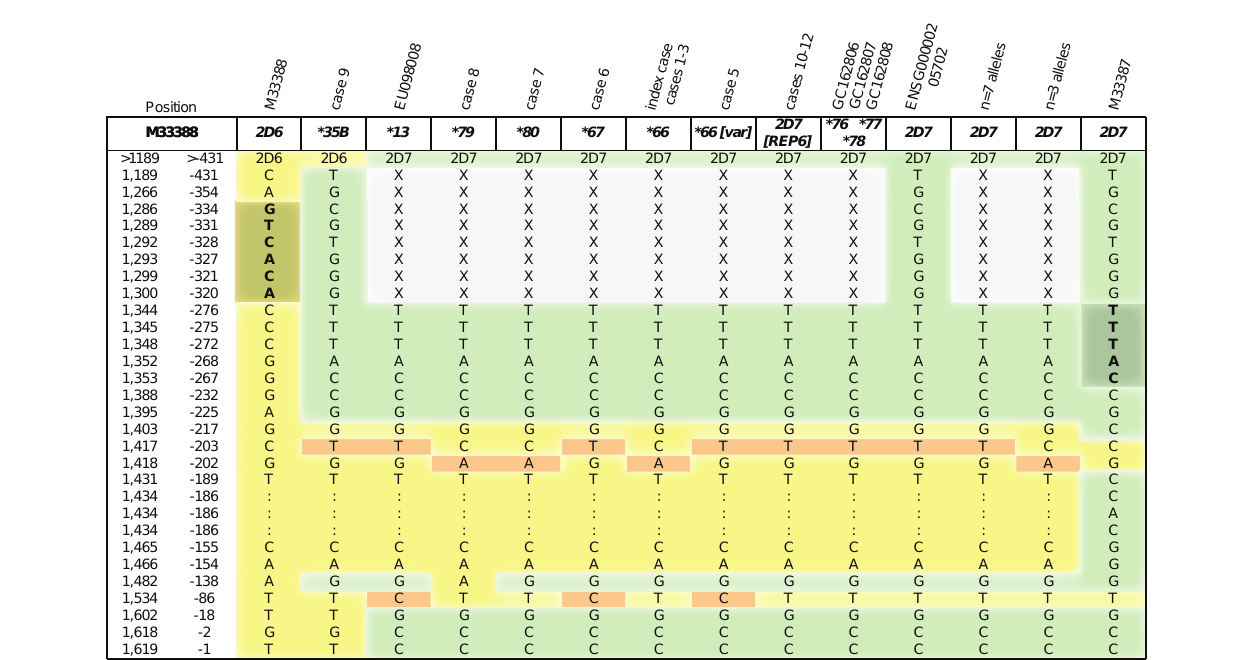
Figure 4 | Comparison of hybrid sequences upstream of exon 1 to CYP2D6 and CYP2D7 references. CYP2D6 sequences are highlighted in yellow, CYP2D7 in green and sequence variation deviating from both in orange. Position numbers are given according to M33388 (first column, 1 = first nucleotide in M33388; second column, − 1 = first nucleotide upstream of ATG start codon. The forward